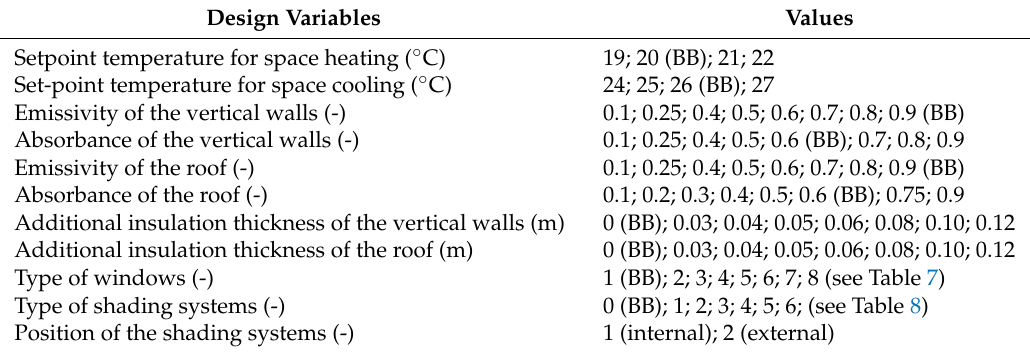
Table 6. Characterization of the design variables of the 1st optimization stage.